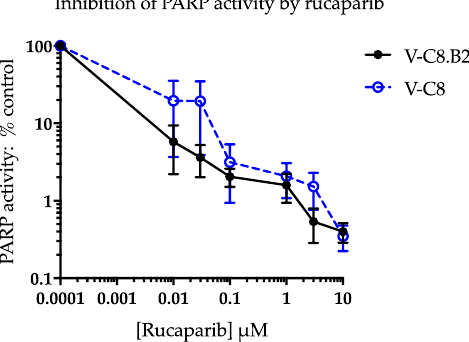
Figure 2. PARP-1 expression, activity, and inhibition by rucaparib in BRCA2 mutant and corrected cells. ( a ) V-C8 and V-C8.B2 cells were exposed to drugs at the indicated concentration for 24 h prior to Western blot. Chemiluminescence was quantified using Syngene software. Bar charts are PARP-1 expression relative to the GAPDH loading control. Data are from a single representative experiment. ( b ) Endogenous PAR was measured in the absence of oligonucleotide and NAD + by reference to a standard curve. Data are the mean and standard deviation of three independent experiments. ( c ) PARP activity (mean pixel values) was measured in the presence of oligonucleotide and NAD + . Data are the mean and standard deviation of three individual experiments. ( d ) PARP activity following exposure to increasing concentrations of rucaparib. Data are the mean and standard error of three individual experiments. 2.3. Rucaparib Activates CHK1 Similarly in Both Cell Lines, and This Activation Is Inhibited by PF-477736